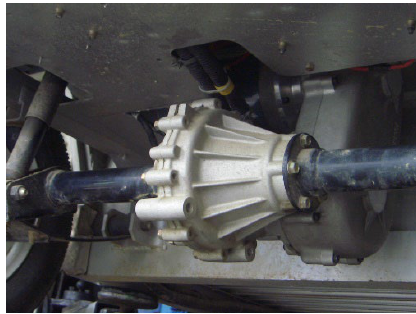
Figure 19. Driving tester concept.